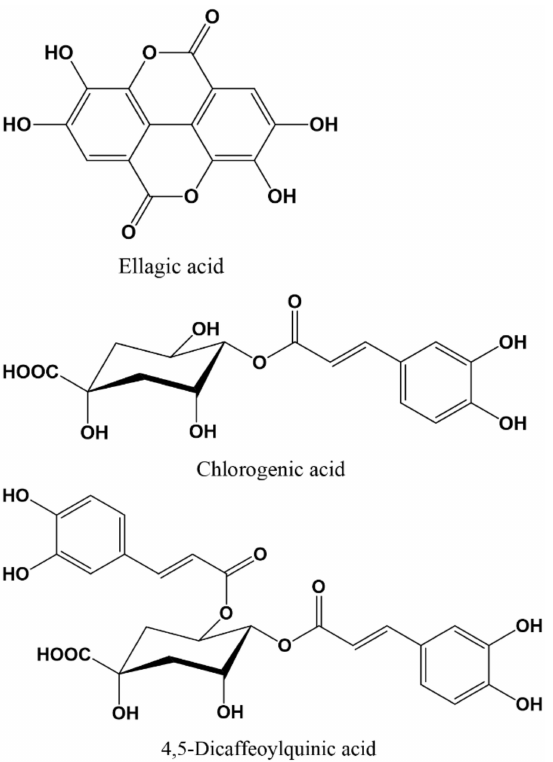
Figure 4. Chemical structures of active some phenol derivatives on GABA A